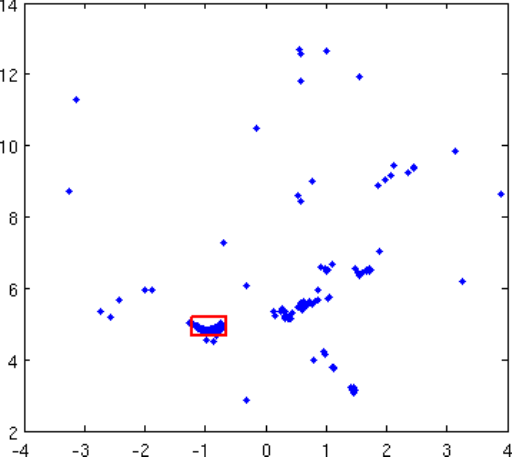
Figure 7: Three circles fitted by different methods to the points selected in Figure 6 after RANSAC filtering. Each point is indi- cated by its 1-sigma uncertainty ellipse. Some remaining outliers are seen, e.g. inside the circles near (-1.05,4.9) or outside the cir- cles near (-0.75,4.85). The blue circle is fitted using the direct al- gebraic method. The green circle was fitted by the Gauss-Newton algorithm assuming isotropic error.The red circle was fitted by the same algorithm assuming the errors indicated by the blue